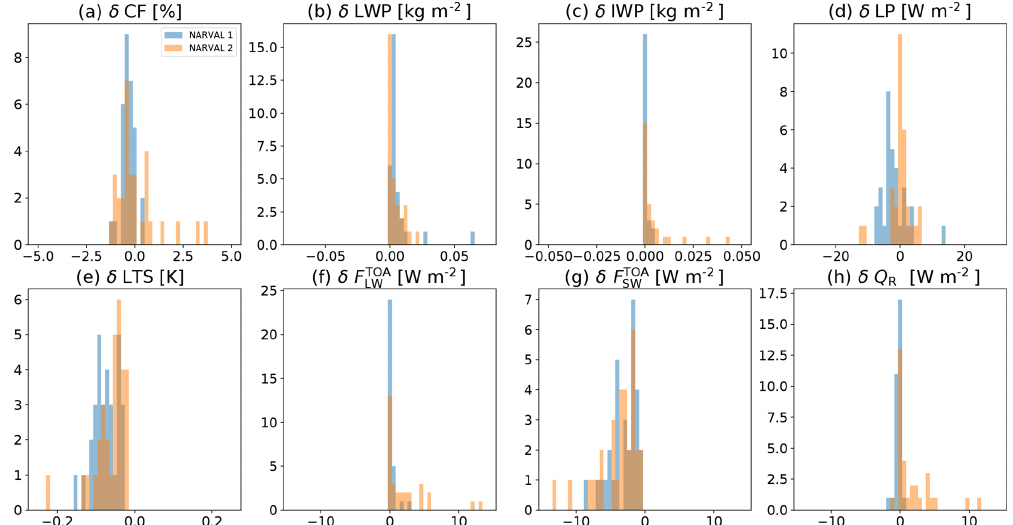
Figure 5. Histograms of the domain and time mean response of cloud and atmospheric properties to CDNC perturbation (polluted simulations minus clean simulations) for each day of the 2 months that were simulated. Blue represents the NARVAL 1 month (December 2013), while orange the NARVAL 2 month (August 2016). (a) Cloud fraction – CF, (b) liquid water path – LWP, (c) ice water path – IWP, (d) precipitation latent heat flux – LP, (e) lower-tropospheric stability – LTS, (f) top-of-atmosphere longwave flux – F TOA flux – F TOA , and (h) atmospheric column radiative term – Q R SW